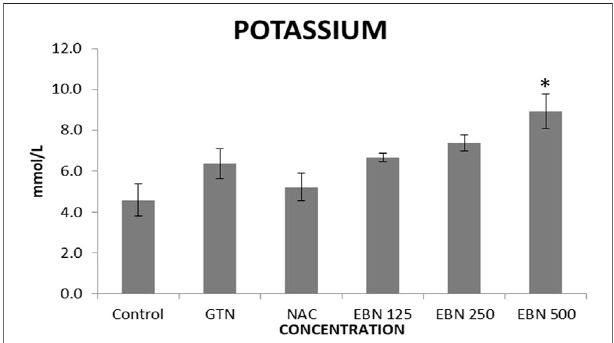
FIGURE 14 | Changes of serum potassium vs different post-treatment group (* p < 0.05 compare to gentamicin group).